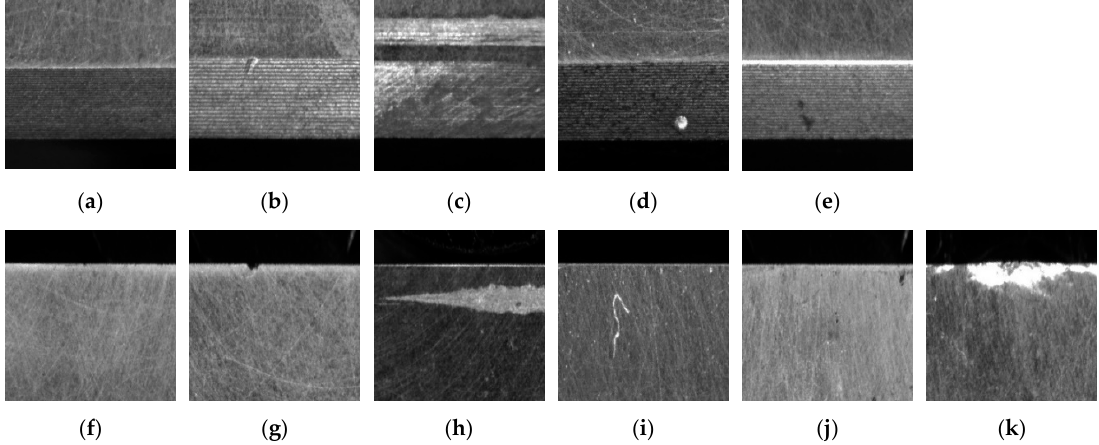
Figure 2. Examples of different roller samples: ( a ) CQ: chamfer qualified; ( b ) CC: chamfer cracks; ( c )